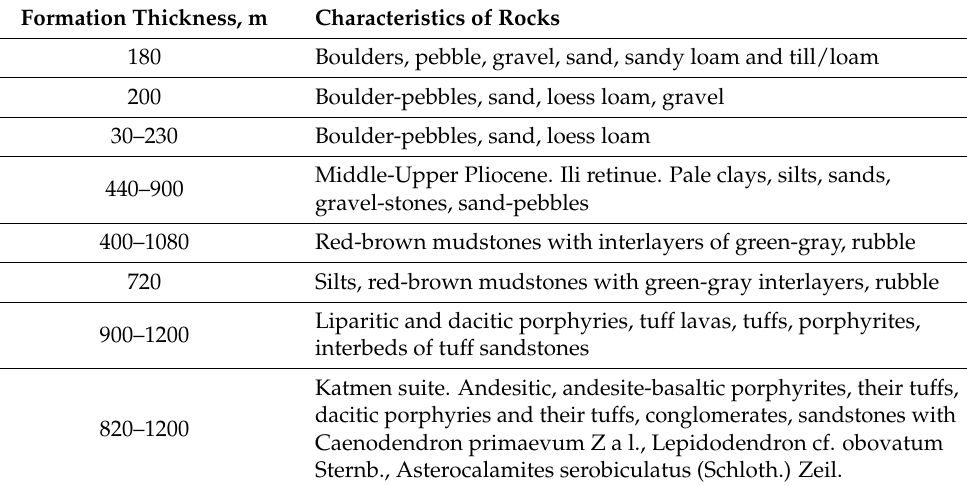
Table 1. Data taken from stratigraphic map of Koksai area [62].